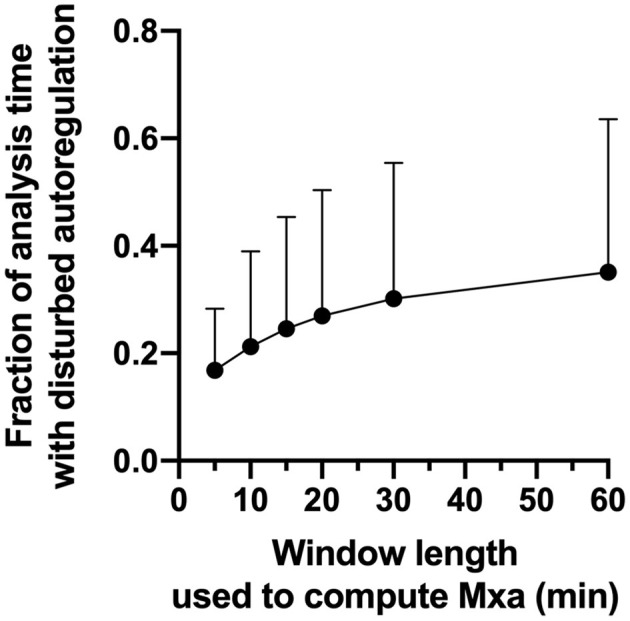
Fraction of the analysis time with disturbed autoregulation as a function of window length used to calculate Mxa. Circles are mean values, Error bars are SD.